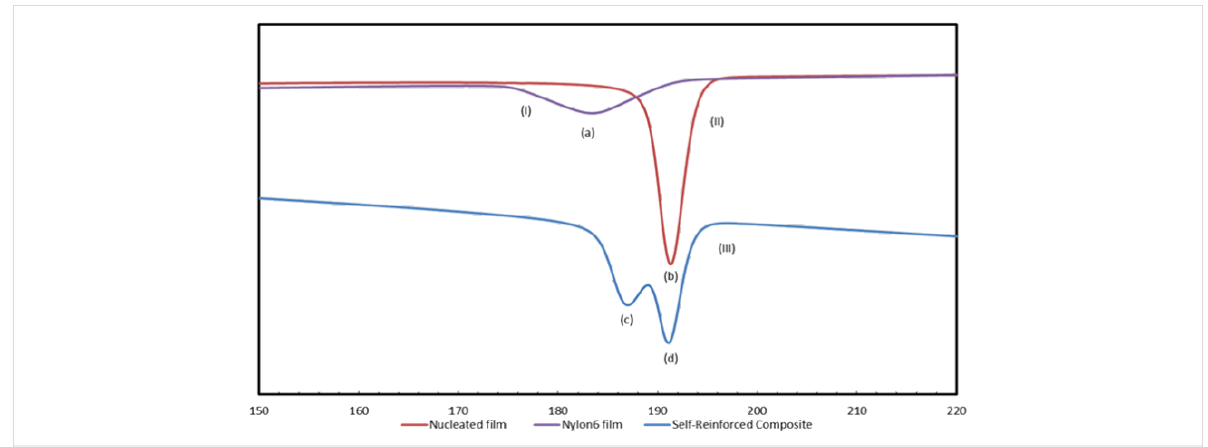
Figure 13: DSC cooling scans from the melts of (I) asr-N-6, (II) nuc-N-6, and (III) asr/nuc N-6 film sandwich. Melt-crystallization peaks (a), (b), (c), and (d) in the DSC scans correspond to T c = 183, 192, 186, and 191 °C, respectively [64].